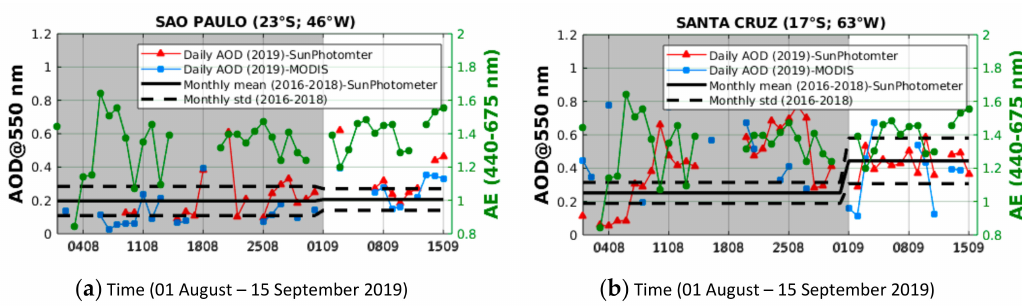
Figure 5. Daily mean AOD values at 550 nm wavelength obtained by sun-photometer and MODIS at ( a ) S ã o Paulo (Brazil) and ( b ) Santa Cruz (Bolivia). The study period is highlighted in grey. For comparison with the background situation, monthly mean sun-photometer over the 2016–2018 period are superimposed (continuous black lines) and framed with ± σ (see the legend). The green lines depict the Angström Exponent (given on the right vertical axe) for 440 and 675 nm